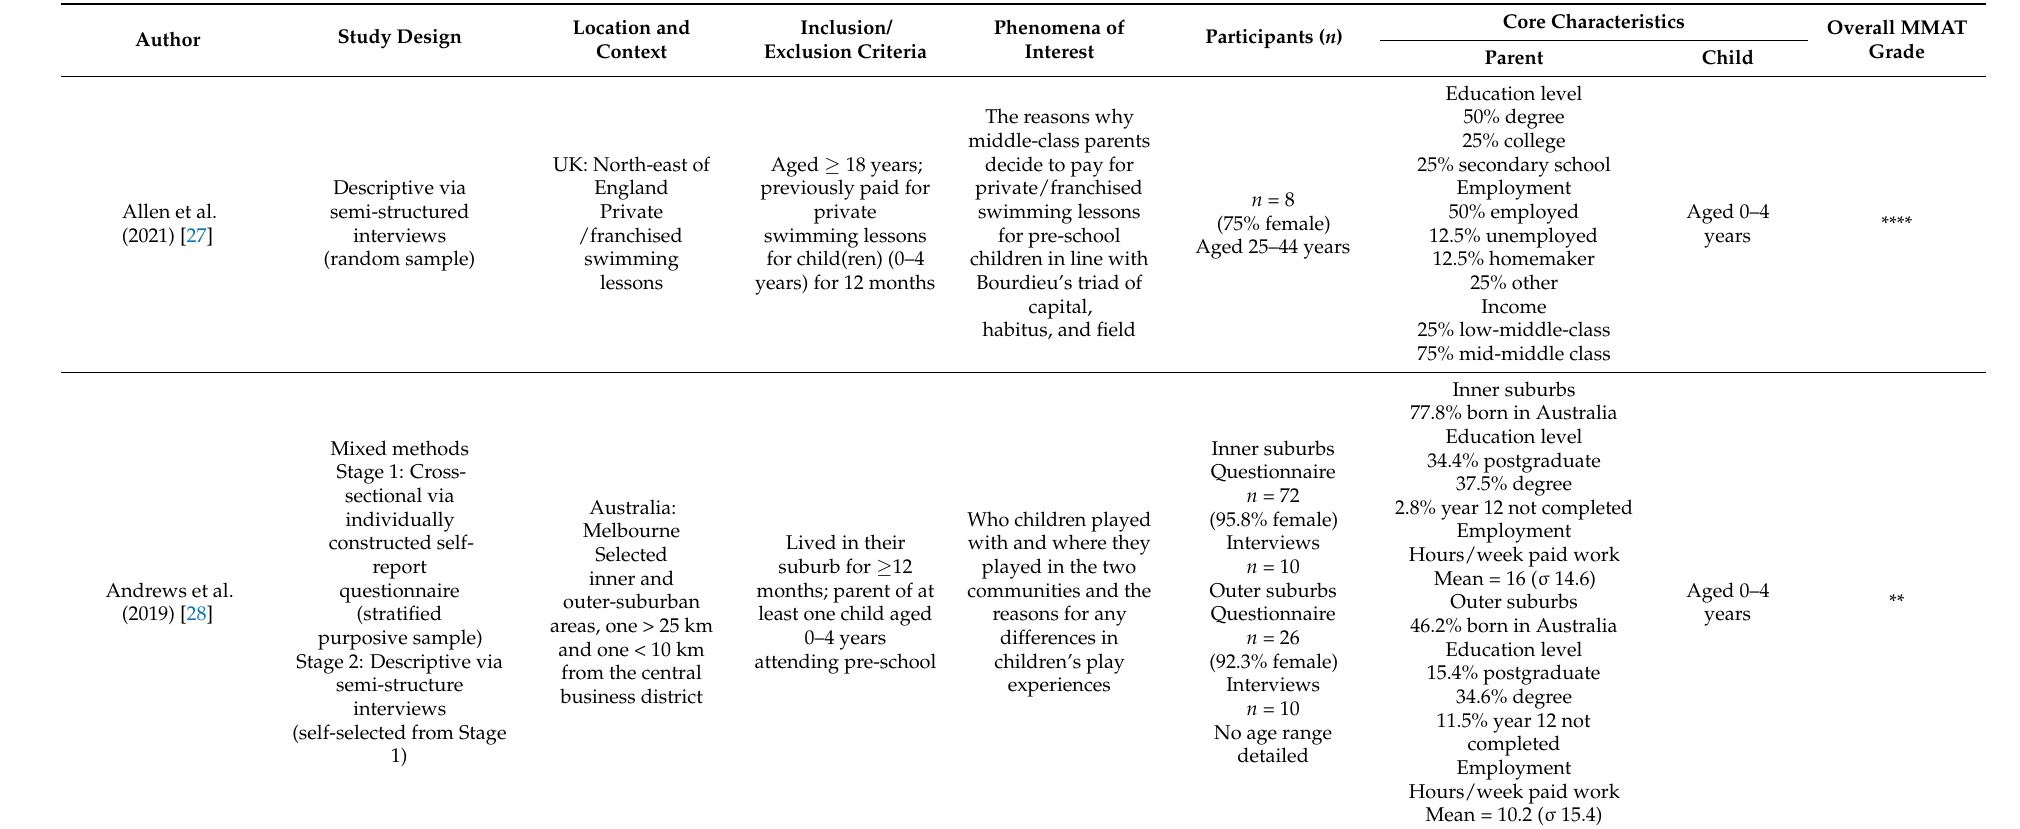
Table 2. Study characteristics and MMAT